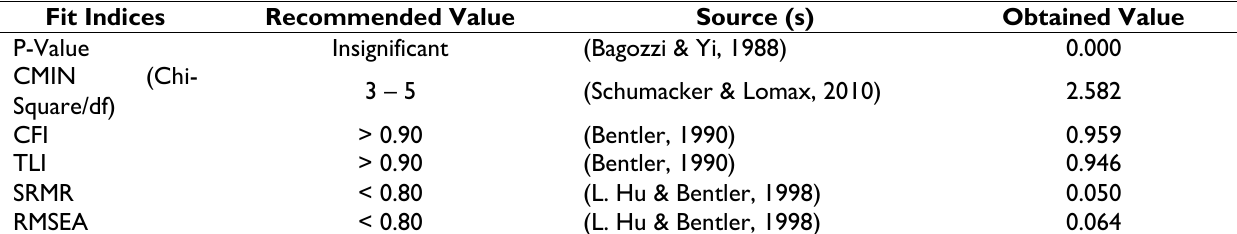
Table 3. Model Fit Assessment (HPWS and EA)